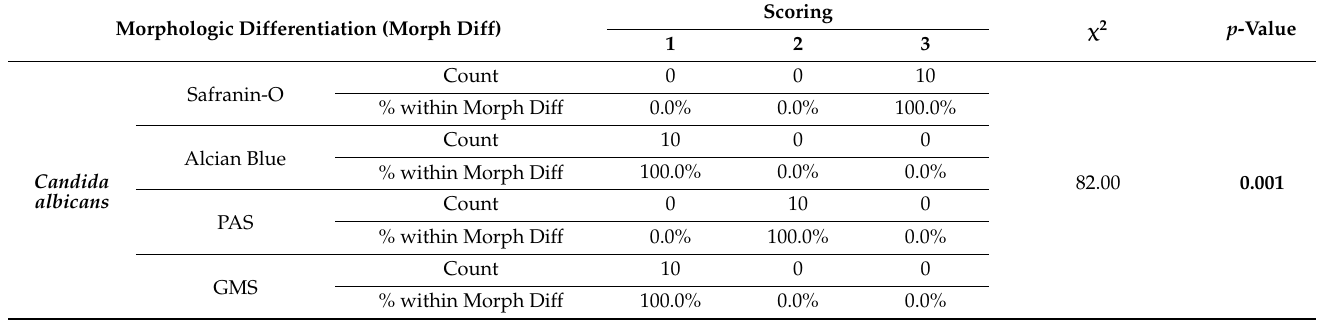
Table 7. Comparison of mean morphologic differentiation (nature of